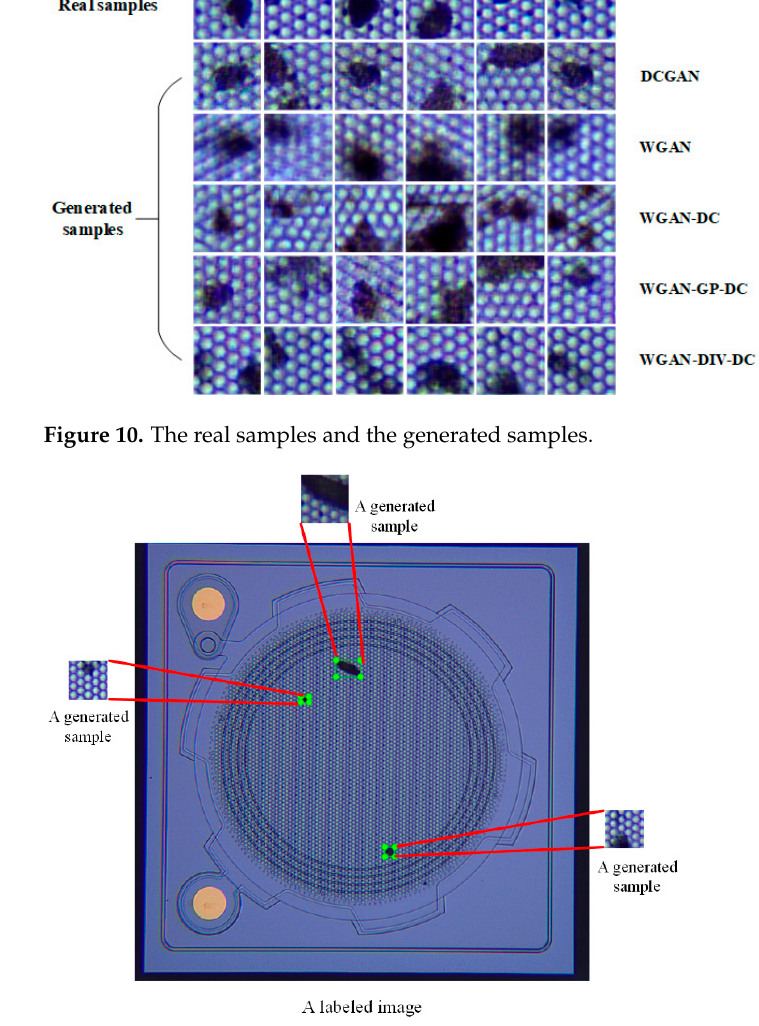
Figure 11. A synthetic image.